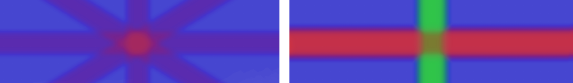
2.3.2 Global mass : Dempster-Shafer theory The DST is used to combine all inputs and gives the final mass m . Let m 1 m 2 two mass functions, the fusion can be computed with the